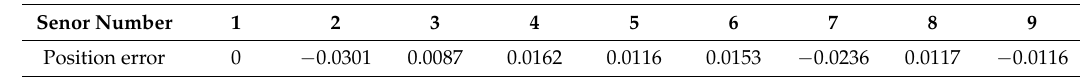
Table 3. Sensor position errors for Figure